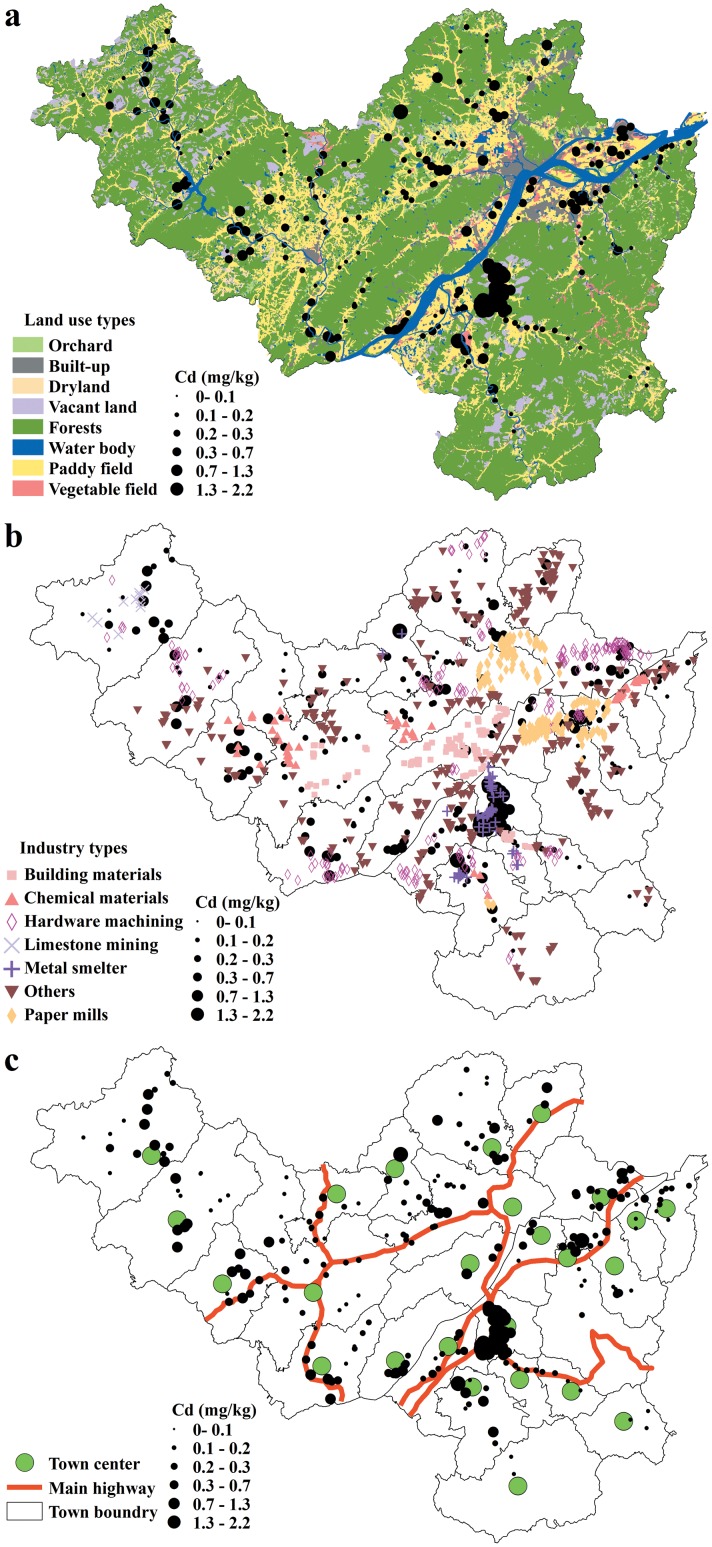
Spatial distribution of the soil Cd concentrations in relation to the (a) land use types, (b) industry types and (c) town center and main highway.